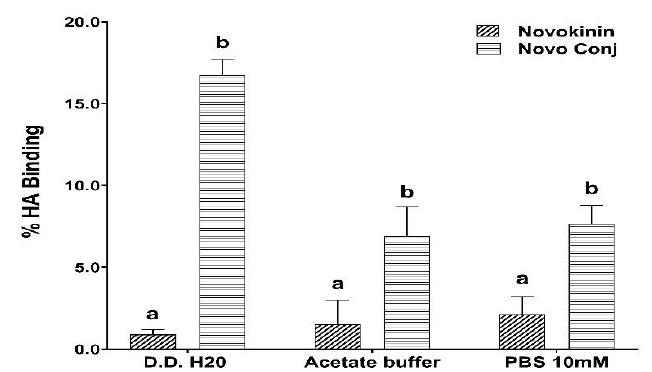
Figure 2. Novokinin conjugate (Novo Conj) shows higher hydroxyapatite (HA) binding affinity than novokinin. Samples were run in triplicate. Data labeled with different letters (a or b) indicate a statistical difference between groups where p < 0.05.